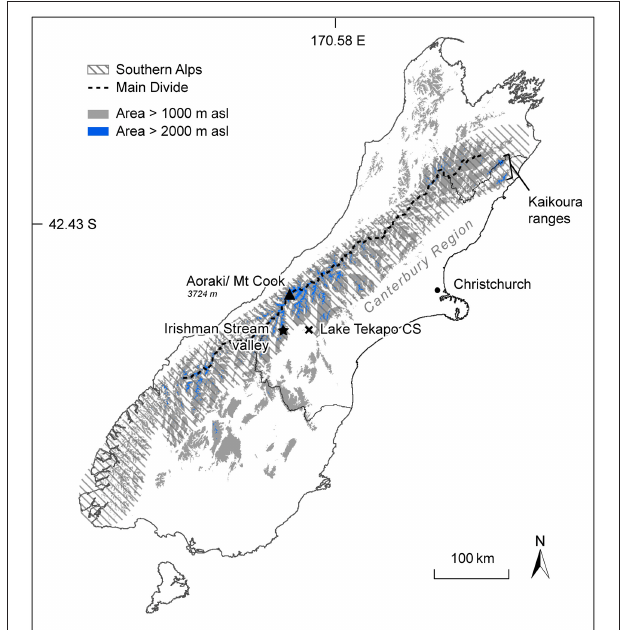
FIGURE 1 | Extent of the Southern Alps on New Zealand’s South Island, as defined in this paper, and locations mentioned in the text. Elevation data: 25m DEM, Barringer et al. (2002), coastline and regional boundaries: Statistics New Zealand